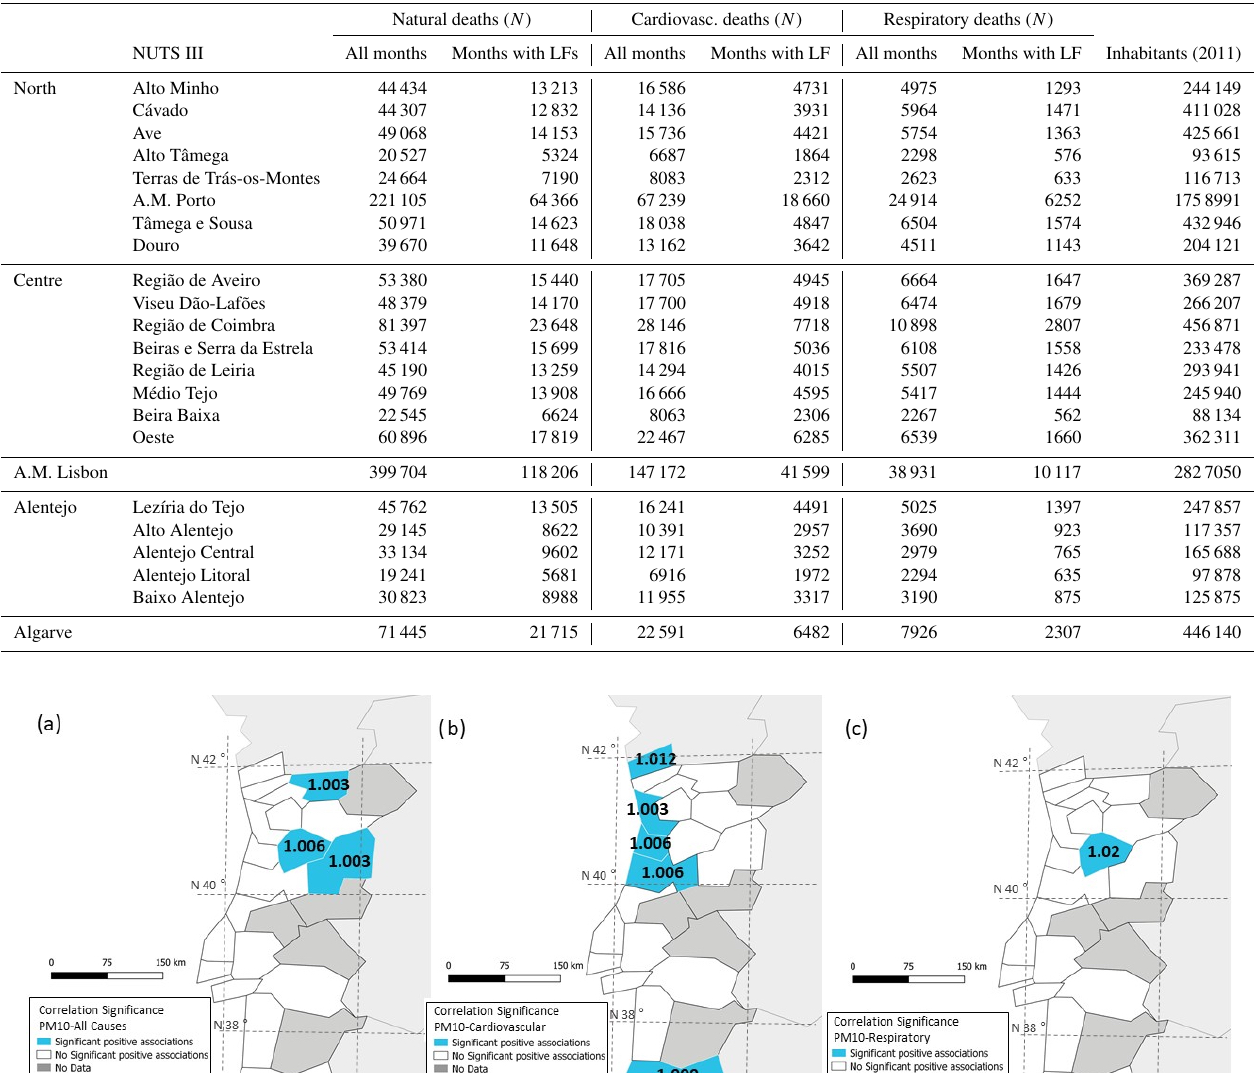
Table 2. Mean number of deaths occurring in months affected by large fires (LFs) from June to September in the period 2001–2016 (total of 64 target summer months) in the 23 NUTS III sub-regions of mainland Portugal.